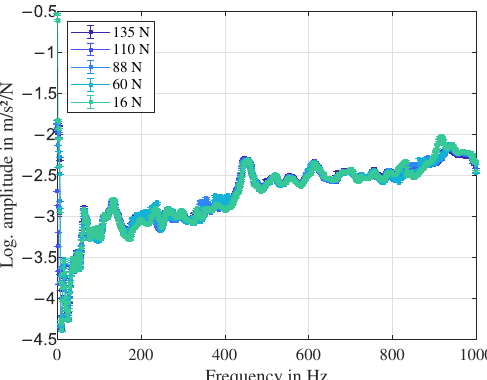
Figure 3. Frequency response functions with different excitation levels within a 95% confidence interval (error bars not perceptible in line